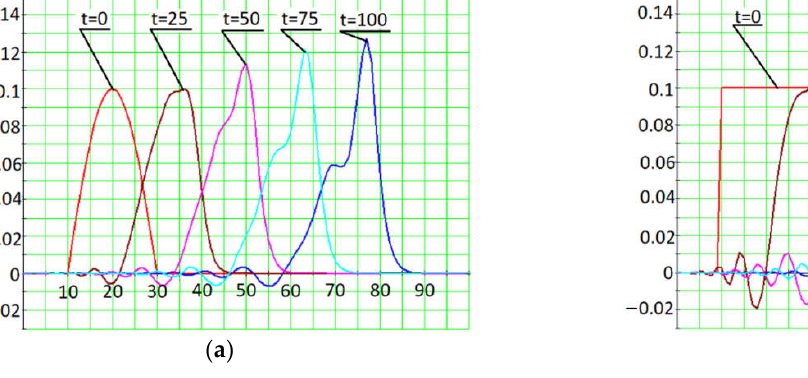
Figure 5. Dynamics of the solution of the KdV problem at the initial distributions in the bell ( a ) and kink ( b ) solitary wave solution form; red line—initial distribution, burgundy line—after 25 s, pink line—after 50 s, light blue line—after 75 s, blue line—100 s.